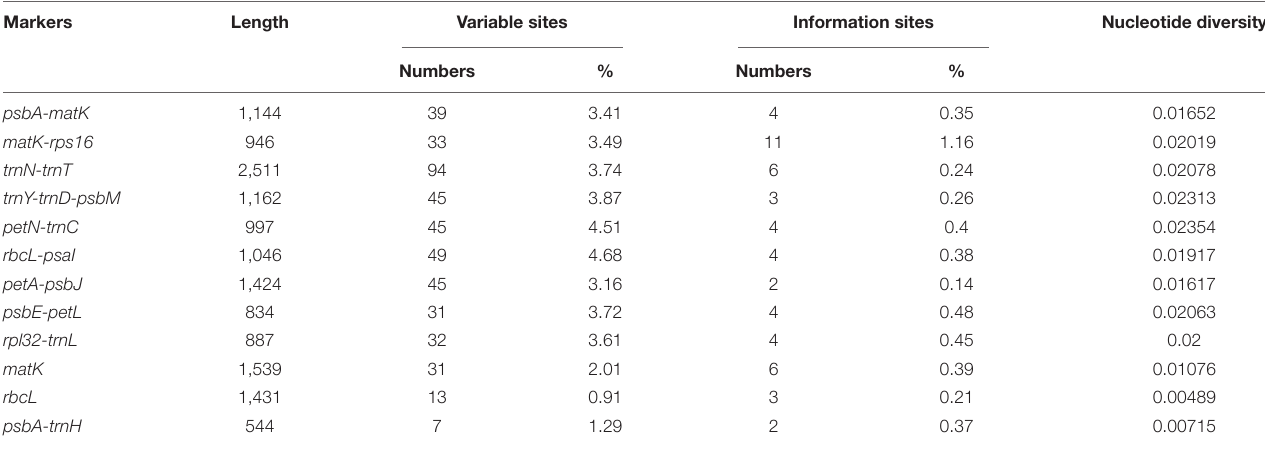
TABLE 4 | Variability of nine novel markers and the three universal chloroplast DNA barcodes in Pennisetum. Markers Length Variable sites Information sites Nucleotide diversity Numbers